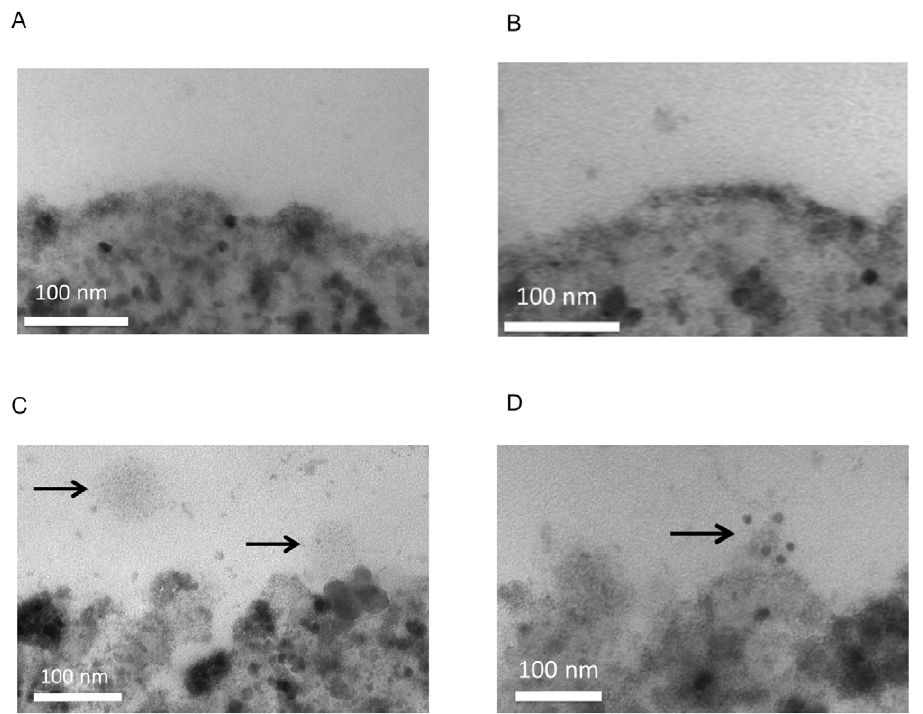
Figure 1. Transmission electron micrographs (TEM) of platelet microparticles ( CD31 + CD42b + ) with immunogold labeling of surface CD39. (A) shows the surface of Dynabeads without CD42b capture antibody after exposure to PPP and (B) shows the surface of Dynabeads coated with IgG isotype control after PPP exposure. No microparticles adhered to the surfaces of these Dynabeads. Subsequent lack of immunogold staining for CD39 was also noted. Platelet microparticles were captured by Dynabeads coated with CD42b antibody (arrows on C, D). The sample imaged in C was not incubated with mouse anti-CD39 antibody conjugated to biotin prior to the addition of streptavidin-linked immunogold. (D) shows positive SA-immunogold labeling of a microparticle which was previously incubated with biotinylated anti-CD39. (all at 180,000 6 magnification).